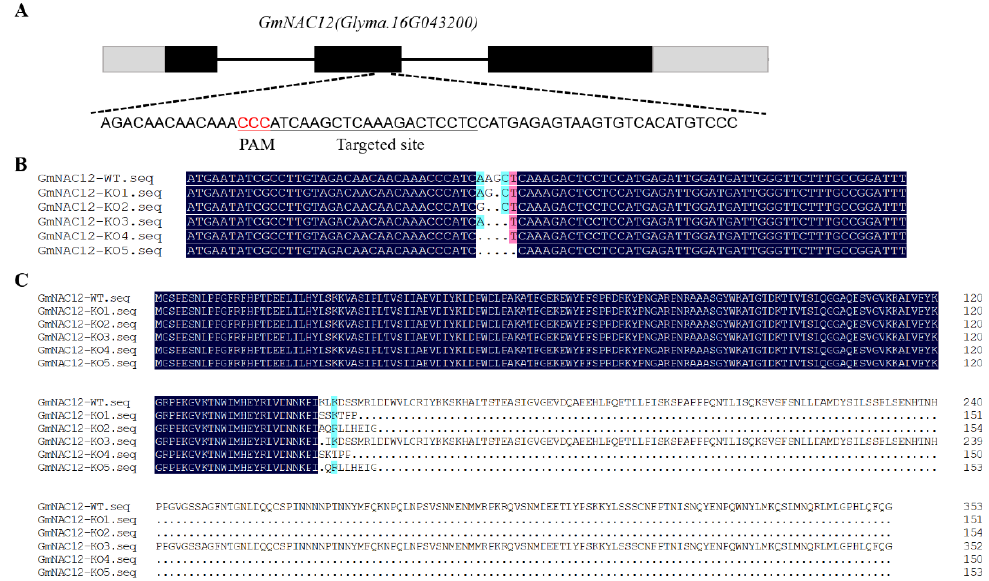
Figure 2. Targeted mutagenesis of GmNAC12 induced by CRISPR/Cas9. ( A ) Gene structures of GmNAC12 with a CRISPR/Cas9 target site designed in the second exon. Black stripe, black line, and grey stripe represent exon, intron, and UTR (untranslated regions), respectively. The underlined nucleotides indicate the target site. Nucleotides in red represent PAM sequences. PAM, protospacer adjacent motif. ( B , C ) DNA sequences and amino acid sequences of wild-type and representative mutation types, GmNAC12-KO1 , GmNAC12-KO2 , GmNAC12-KO3 , GmNAC12-KO4 , and GmNAC12- KO5 , induced at the target site. Underline, insertions. Dashes, deletions.